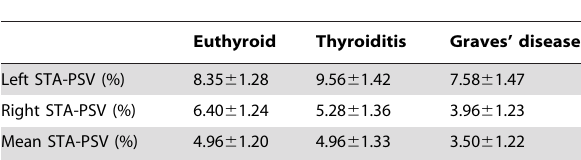
Table 3. Coefficient of variation of the STA-PSV detection.